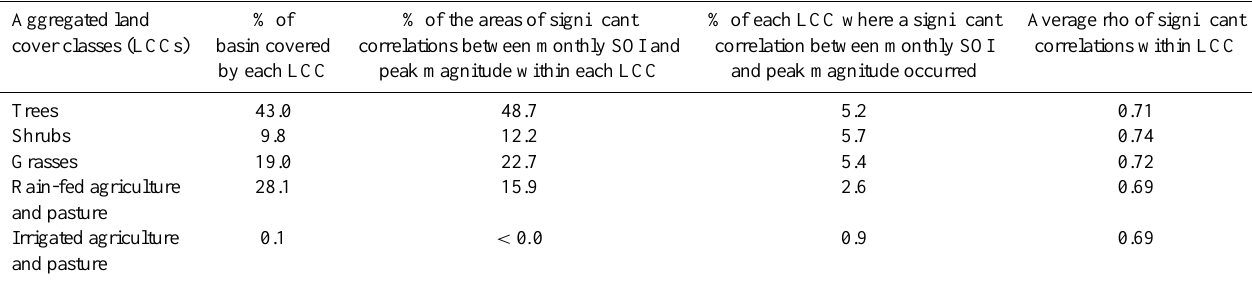
Figure 7. Mean of the cycles’ integral greenness across the time series (top-left panel in day units) and standardized anomaly of each cycle’s Fig. 7 2 integrated greenness. The standardized anomalies of the cycles are shown in the year when the cycle started. For example, for a site with six phenological cycles across the time series that started in 2001, 2002, 2003, 2005, 2008 and 2010, the cycles’ standard deviations are shown in 2001, 2002, 2003, 2005, 2008 and 2010. All other years are shown in gray, as no phenological cycle start was detected for those years. The white circle in the top-left panel marks the OzFlux site shown in Fig. 2. Table 2. Percentage distribution of the most significant correlation relationships between monthly SOI and phenological peak magnitude per land cover class across the MDB. Shown are percentages of the MDB occupied by different land covers, the percentage of basin-wide significantly correlated areas per land cover, the percentage of significantly correlated land cover classes and the average rho value per land